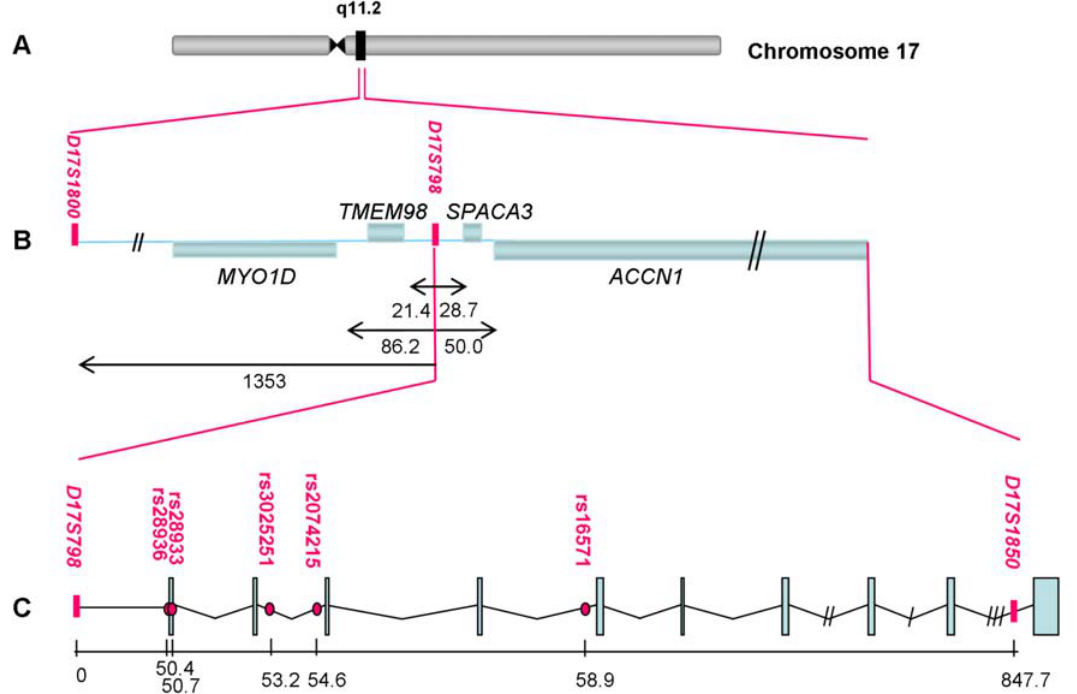
Figure 1. Studied genomic region. This figure consists of three panels, (A,B,C). Panel A shows the location of the 17q11.2 region on Chromosome 17. Panel B maps the position of four known genes (blue rectangles) in the region around D17S798, where a horizontal line represents DNA sequence, and a pink bar marks the location of microsatellites D17S798 and D17S1800. The diagram conveys the fact that TMEM98 and SPACA3 (represented above the horizontal line) lie on the forward helix, whereas Myo1D and ACCN1 (represented below the horizontal line) lie on the reverse helix. Panel C zooms on gene ACCN1, showing the locations of the genotyped markers relative to D17S798, in Kb. In this latter panel, the horizontal line represents genomic DNA, the pink dots represent the SNPs we have genotyped, the pink vertical bar represents microsatellite D17S1850, the blue bars represent ACCN1 exons and the wavy solid line between exons corresponds to the ACCN1 introns. The ACCN1 gene is located on the reverse strand, so the portion of ACCN1 near D17S798, where SNP rs28936 and SNP rs28933 are located, is the 3 9 UTR-exon10 region of the gene. The width of the introns and exons in panel C is proportional to the actual length, with the exception of the first three very long introns (right portion of the panel) which have been shortened. Gaps are represented by diagonal bars: three bars (intron1-2)=1,043,911 base pairs; two bars (intron 3–4)=60,470 base pairs; one bar (intron 2–3)=22,926 base pairs